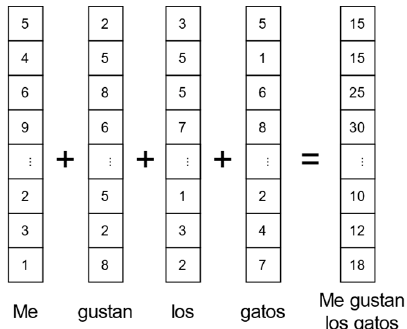
Figure 5. Word Embedding approach feature vector.